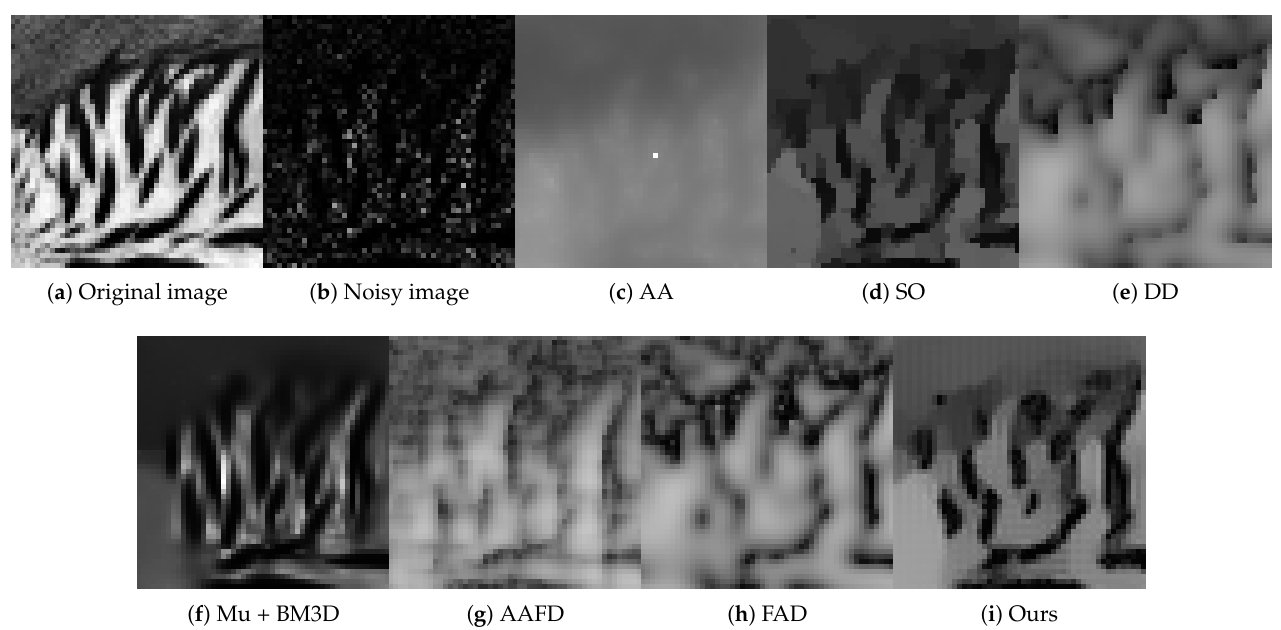
Figure 7. The zoomed version of the Parrot image and its corresponding denoised